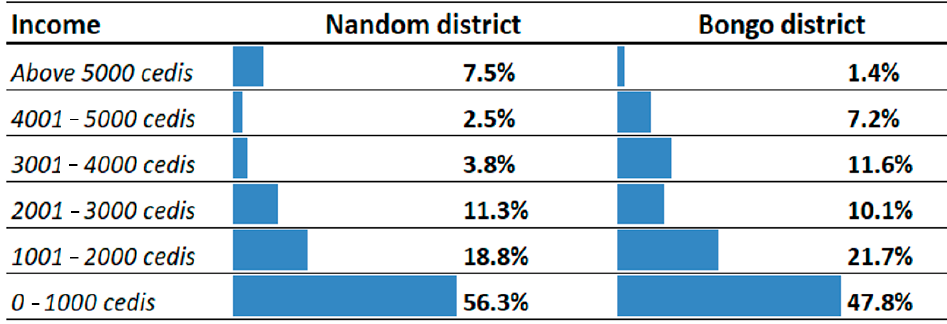
Figure 7. Farming income and the ability to pay for all household expenses in the districts.